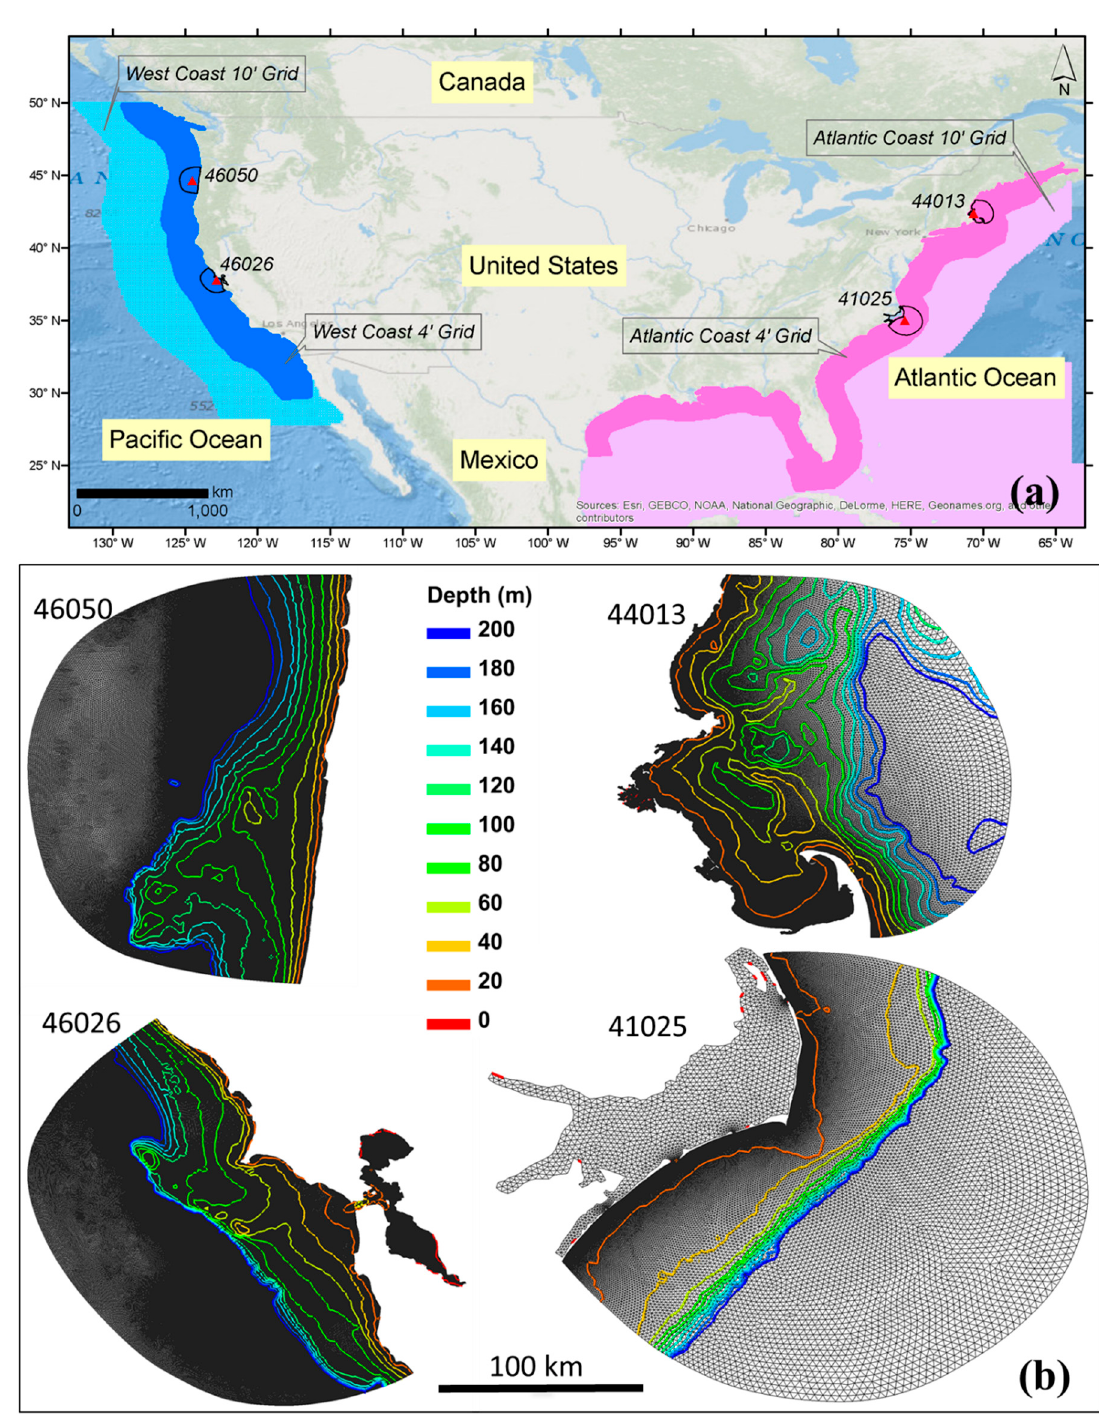
Figure 2. ( a ) Locations of the four selected NDBC buoys (triangles) and the corresponding UnSWAN local domain boundaries. The NOAA’s 10-arc minute and 4-arc minute WWIII domain coverages for the U.S. West Coast and Atlantic Coast are also indicated in the figure. ( b ) The four UnSWAN model grids with depth contours.